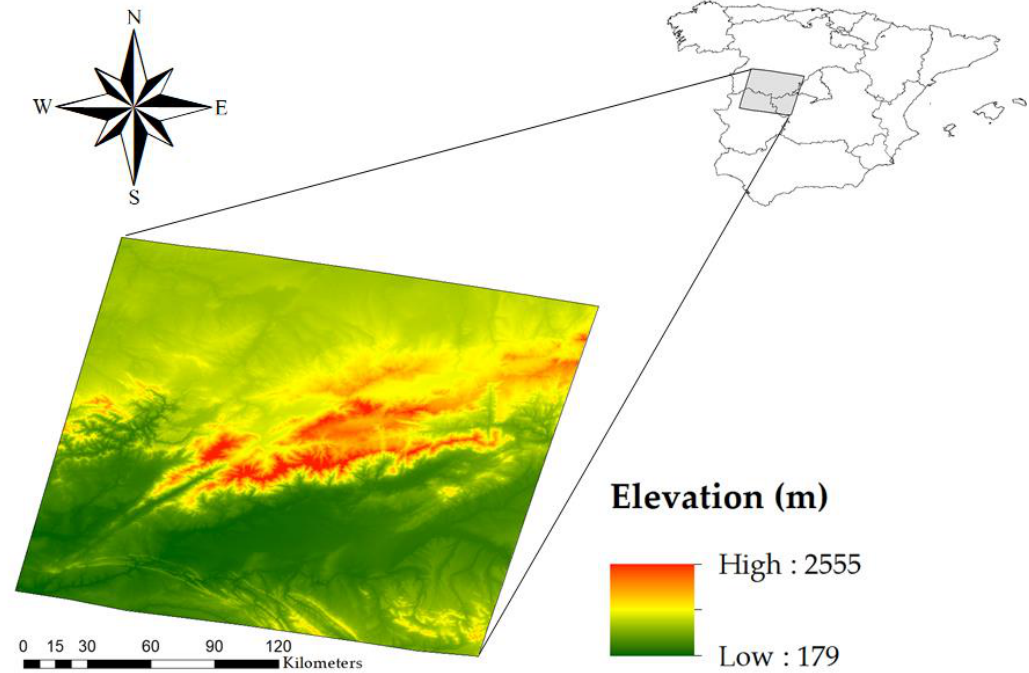
Figure 1. Location of the study area in west-central Spain. The digital terrain model has a spatial resolution of 30 meters and was obtained from the Shuttle Radar Topography Mission (SRTM). The areas with the highest elevation are shown in red, while the areas with the lowest elevation are shown in green.